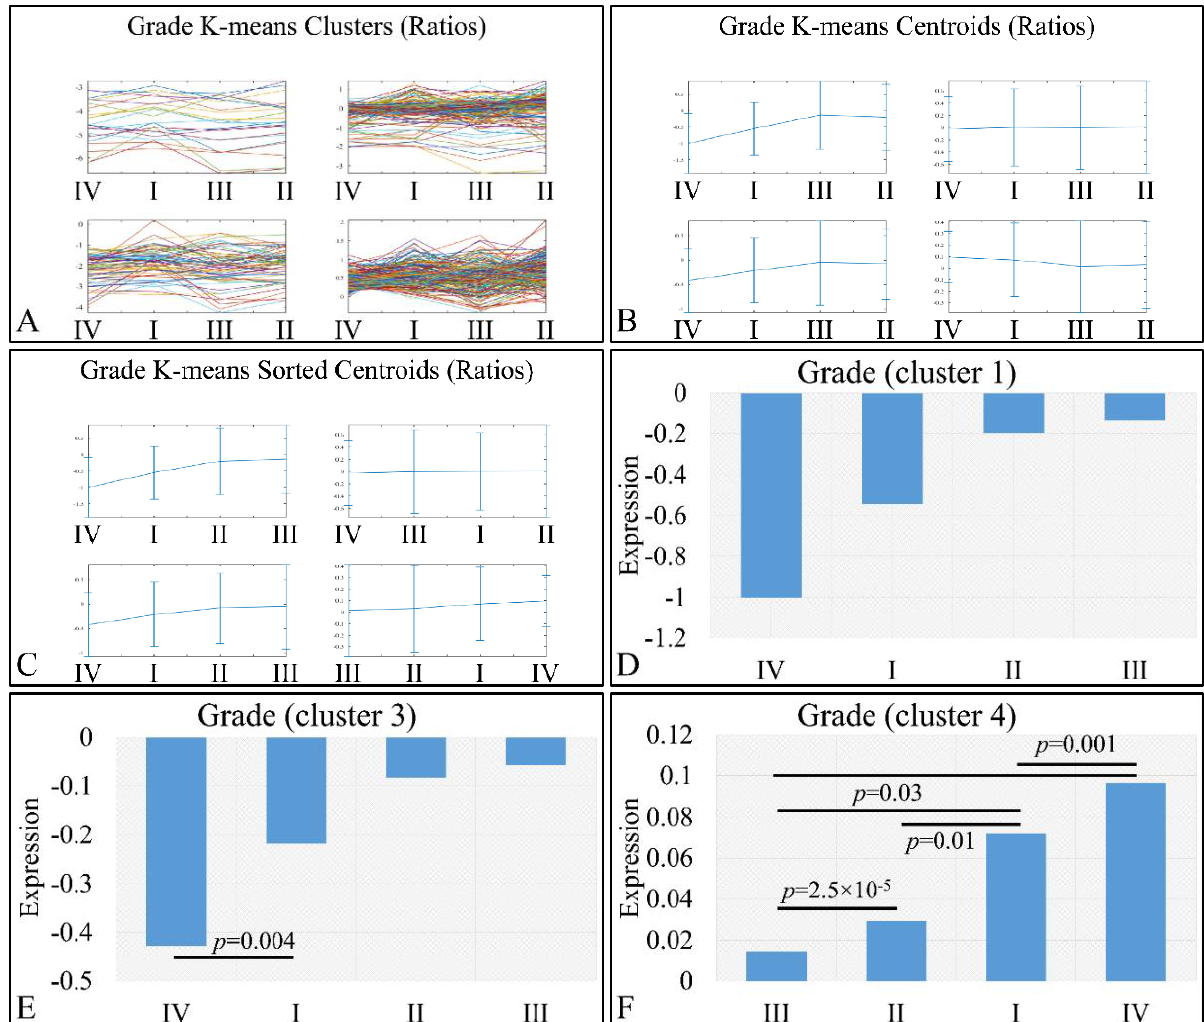
Figure 11. Expression patterns of miRNAs with respect to tumor grade utilizing k-means clustering and the log 2 -transformed ratios (tumors/controls). Tumor grade includes the classification of tumors into four general categories: tumor grading from I to IV, which is presented with the respective clusters ( A ), the centroids ( B ) and the sorted centroids ( C ). Clusters 1 ( D ) and 3 ( E ) manifested an ascending pattern from controls to grade IV, I, II and III, while cluster 4 manifested an ascending order from grade III to grade I and IV ( F ). Significant differences between tumor grades are noted in the respective clusters (Legend: I: tumor grade I, II: tumor grade II, III: tumor grade III, IV: tumor grade IV).